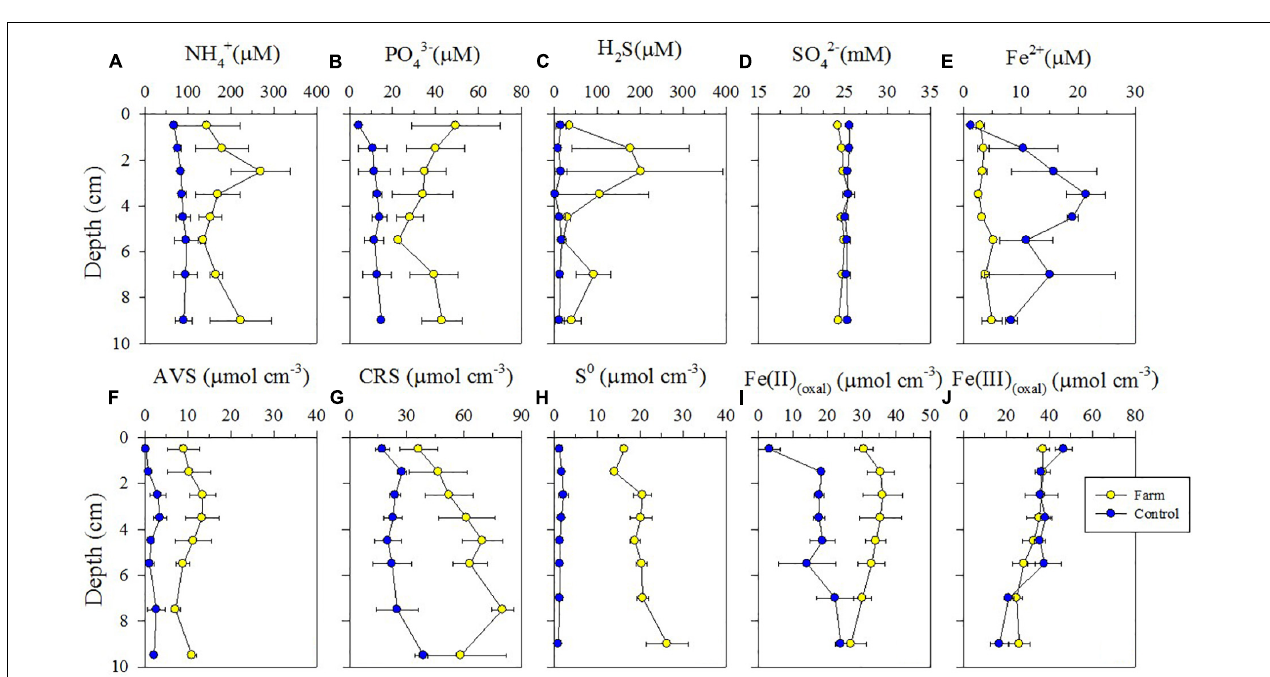
Values represent average ± 1 SD on the duplicate or triplicate samples.